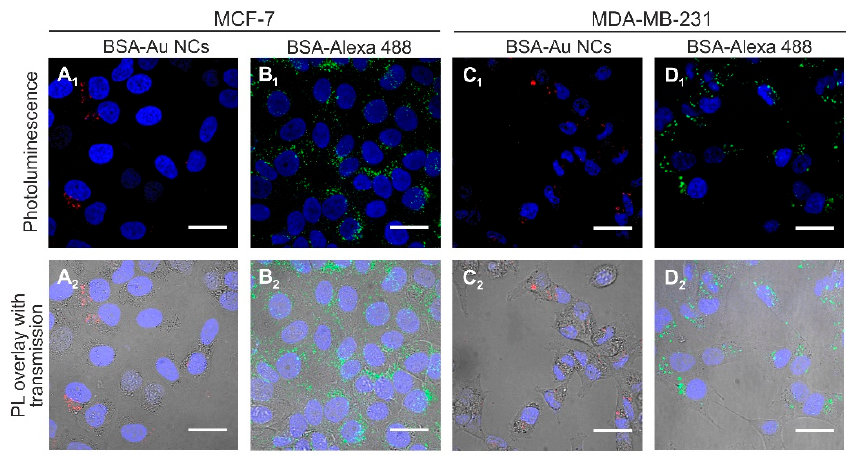
Figure 2. Accumulation of photoluminescent BSA-Au NCs ( λ ex = 488 nm) ( A 1 , A 2 , C 1 , C 2 ) and BSA-Alexa conjugate ( λ ex = 488 nm) ( B 1 , B 2 , D 1 , D 2 ) in MCF-7 and MDA-MB-231 cells after 24 h of incubation, nuclei stained with Hoechst 33258 ( λ ex = 405 nm). Scale bar is 30 µ m.